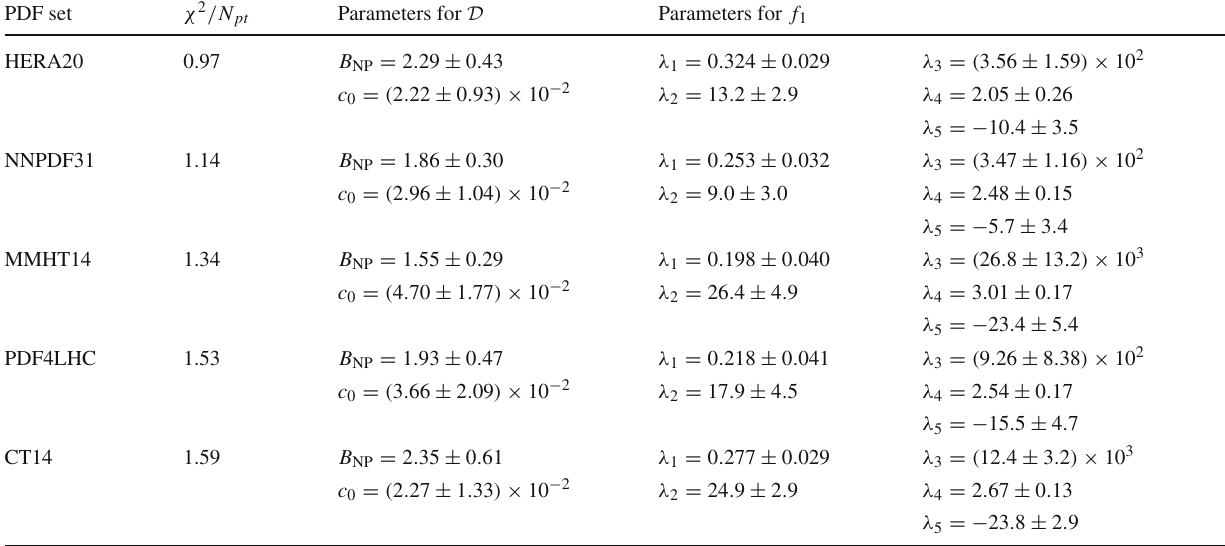
Table 5 Values of χ 2 and NP parameters obtained in the fit of DY set of the data with different PDF inputs. Each set of PDF provide the corresponding value of α s ( M Z )